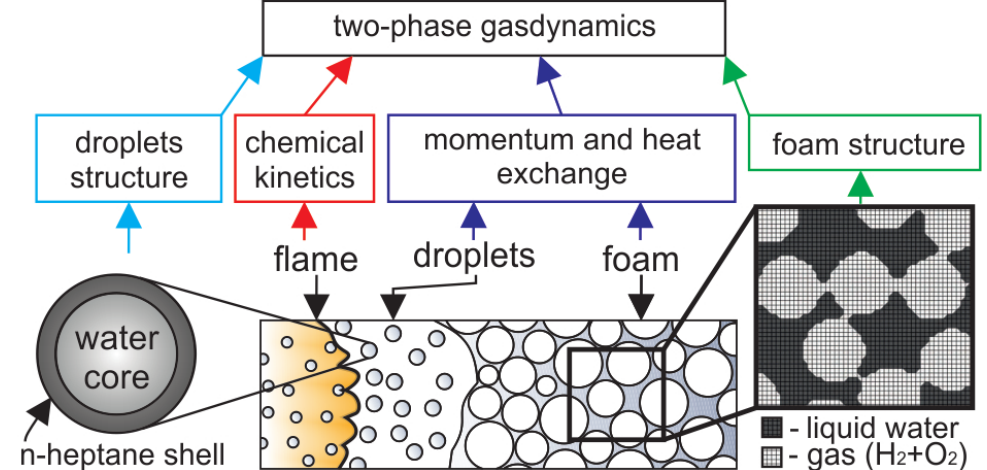
Figure 1. Schematic of the numerical model and problem setup. The flame propagates downwards through the foam that decays into the droplets in the pre-flame zone (for convenience, the channel is shown horizontally. The top end is to the left, the bottom is to the right). The numerical model based on the two-phase gas dynamics includes submodels of momentum and heat exchange in the regions of foam and droplets, combustion kinetics, the structure of the emulsion droplet, and the non-uniform spatial distribution of liquid in the